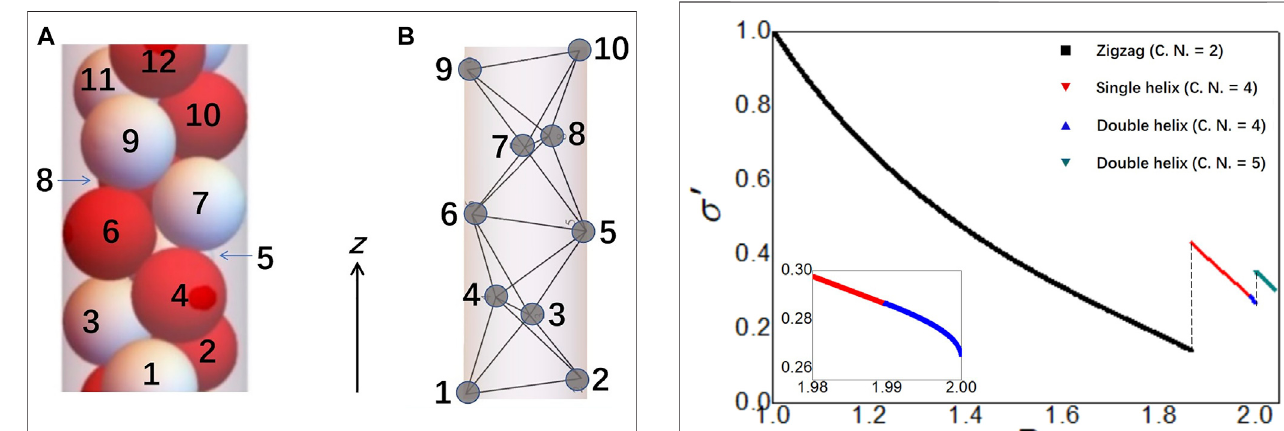
FIGURE 4 | Schematic illustration of (A) a double-helix structure at (cid:1)(cid:1) √ D ∈ ( 2 , 1 + 3 3 /5 ) and (B) the corresponding network of inter-particle contacts. The spheres in the structure are indexed in ascending order of their vertical z -positions. Each sphere is not only in contact with its two nearest neighbours and two next-nearest neighbours but also with one of its third-nearest neighbours, such that there exist quartets of mutually touching spheres, in the form of {1, 2, 3, 4}, {3, 4, 5, 6}, {5, 6, 7, 8} ... , across the structure.